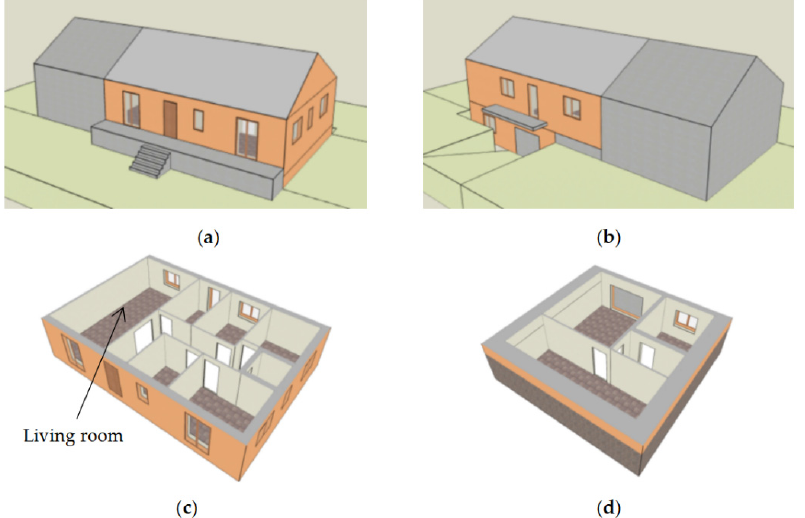
Table 3. Occupancy density and metabolic rate.